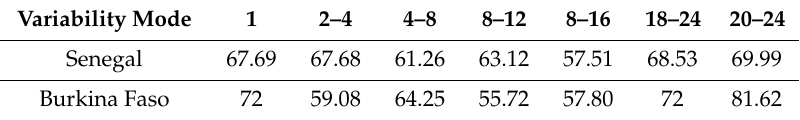
Table 4. Percentage of consistency between precipitation and the TNA index